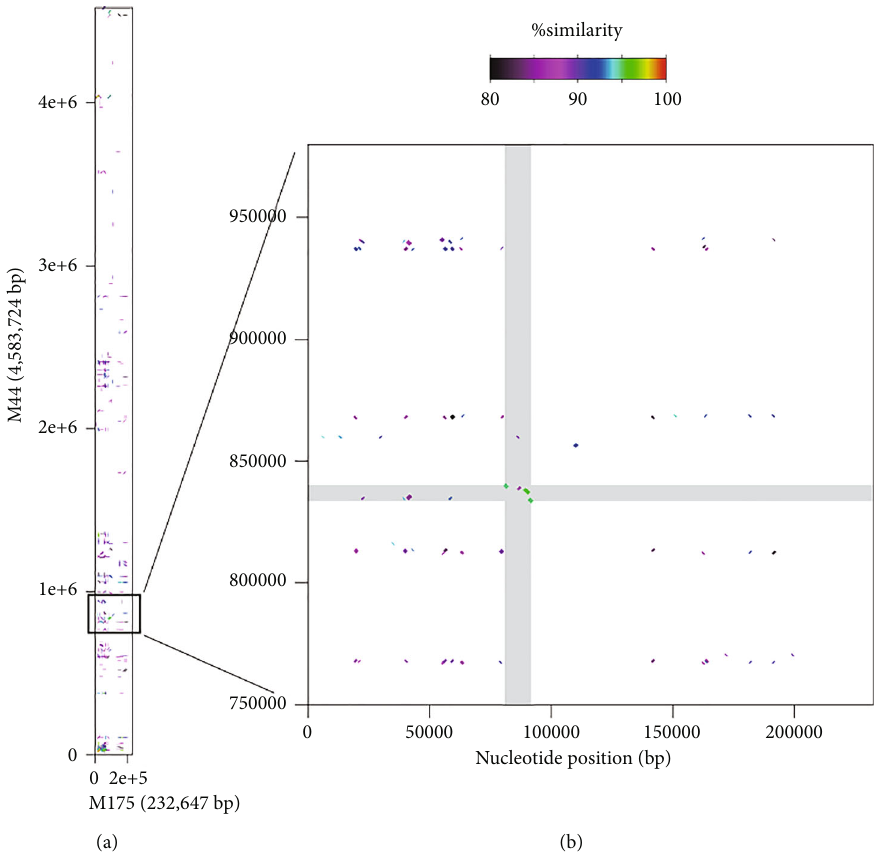
Figure 1: Sequence comparison between PBT male sca ff olds M175 ( x -axis) and M44 ( y -axis). (a) indicates the full-size comparison (232,647 bp vs. 4,583,724 bp), and the boxed region is enlarged at (b). In (b), SLR